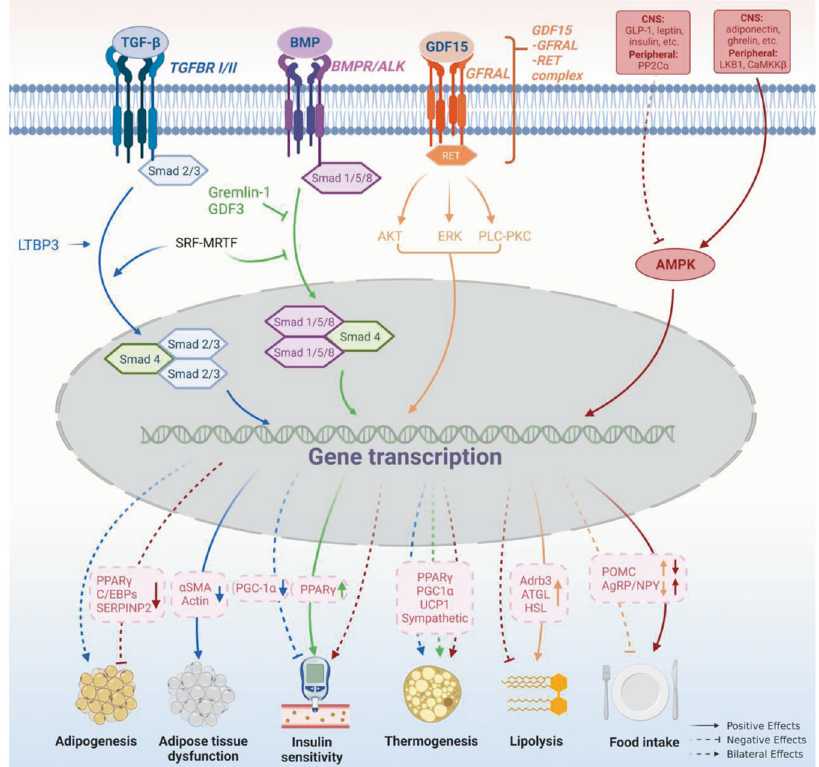
Fig. 3 TGF- β and AMPK signaling pathways in obesity pathogenesis. The TGF- β superfamily consists of TGF- β 1-3, GDFs, BMPs, etc., which play a diverse role in the development of obesity. TGF- β shows dual effects on adipogenesis/adipocyte differentiation. TGF- β inhibits MSC adipocyte commitment by phosphorylating and suppressing PPAR γ and C/EBPs expression, through Smad3 signaling. However, pulsed TGF- β 1 administration during the commitment phase shows a promotion effect on adipogenesis in MSC by down-regulating SERPINB2 expression. In adipocytes, TGF- β signaling is involved in adipose tissue dysfunction by enhancing the expression of myo fi broblast signature genes. The role of TGF- β in BAT-associated thermogenesis is also controversial. Activation of TGF- β signaling by LTBP3 promotes WAT browning by modulating UCP1 expression, while hepatic TGF- β signaling contributes to HFD-induced steatosis and obesity by reducing mitochondrial respiration and inhibiting white-to-beige fat conversion. In addition, SRF - MRTF - axis which transcriptionally enhances the TGF- β but attenuates BMP signaling pathway suppresses brown adipogenesis. TGF- β /Smad3 signaling also plays a negative role in insulin sensitivity by suppressing PGC-1 α expression in adipose tissue. BMP seems to play a contrary role to TGF- β in the regulation of insulin sensitivity by up- regulating PPAR γ expression. Similar to TGF- β , the role of BMP in BAT-associated thermogenesis is inconsistent. BMP4 promotes WAT browning and this process is inhibited by Gremlin-1. However, BMP-4 signaling during the terminal differentiation phase can impair the acquisition of a mature brown adipocyte phenotype. GDF15, another member of TGF- β superfamily, was identi fi ed as a potential target for the treatment of obesity. By interacting with GFRAL and followed by the activation of AKT-, ERK-, and PLC-PKC signaling pathway, GDF15 stimulates lipolysis by up-regulating Adrb3, ATGL, and HSL expressions. It also inhibits food intake in a CNS-dependent manner via an unknown mechanism. AMPK is a heterotrimer complex. It is activated by adiponectin, ghrelin, etc. in CNS and LKB1 and CaMKK β in peripheral tissue, and inactivated by GLP-1, leptin, etc. in CNS and PP2C α in peripheral tissue. Activation of AMPK in CNS results in hyperphagia, insulin resistance, decreased thermogenesis, and weight gain. While, in adipocytes, it results in inhibited adipogenesis, insulin sensitiveness, enhanced thermogenesis, and weight loss. However, AMPK limits lipolysis since AMPK is an enzyme in case of energy shortage